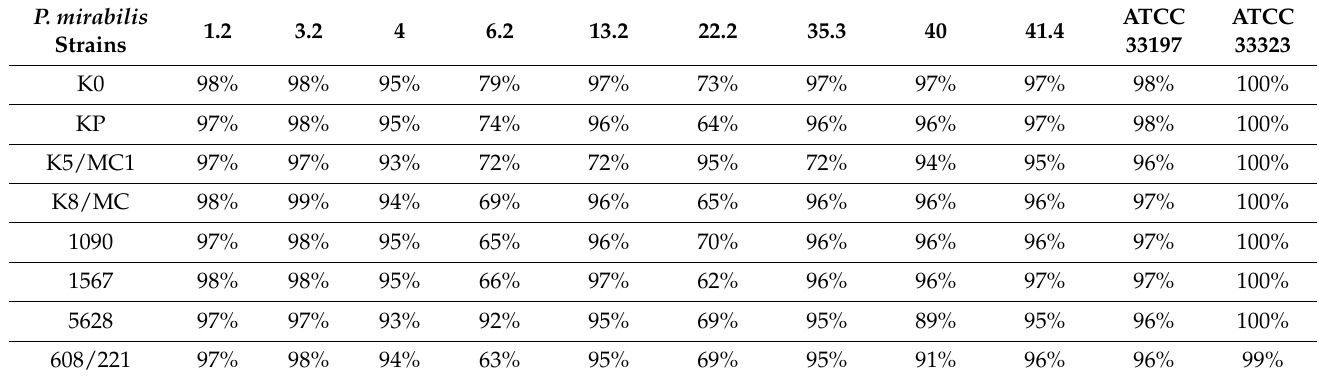
Table 2. The percentages of P. mirabilis isolate growth inhibition according to broth microdilution method. The results are presented as the mean ± standard deviation (SD) of three experiments. All the results are statistically significant ( p < 0.05) according to Cochran’s Q